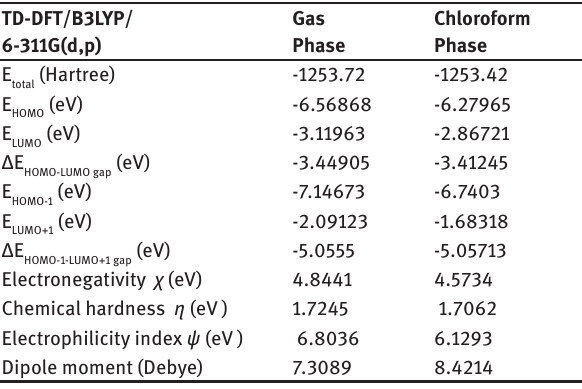
Table 2: Calculated molecular orbital energy values of the title molecule. TD-DFT/B3LYP/